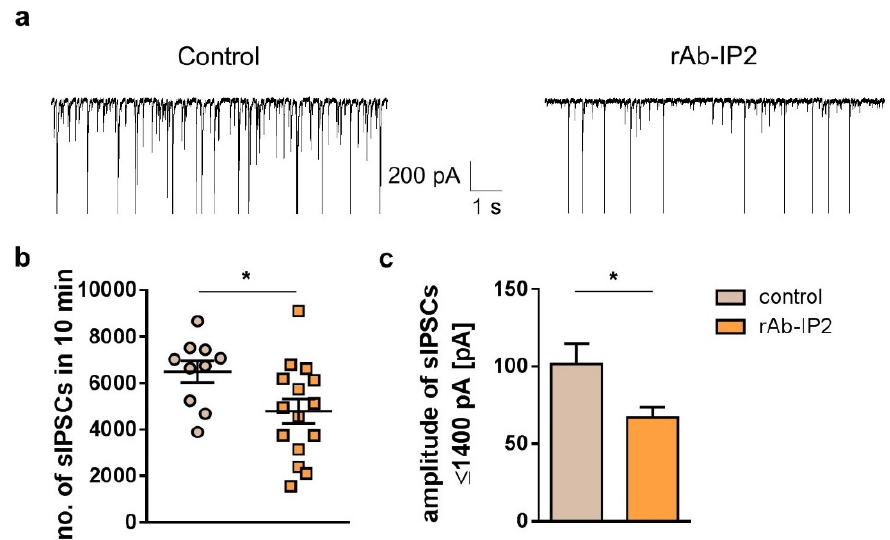
Figure 2. Incubation with the recombinant GABA A receptor autoantibody rAb-IP2 led to both de- creased number and amplitude of spontaneous inhibitory postsynaptic currents (sIPSCs) in pyramidal CA3 neurons. ( a ) Exemplary traces show GABA-mediated synaptic currents in rAb-IP2-incubated pyramidal neurons and controls. For illustration purposes, the amplitude of the high-amplitude currents is cut at 800 pA. ( b ) rAb-IP2-incubated neurons showed a significantly reduced number of sIPSCs in comparison with controls. ( c ) rAb-IP2 led to a significant reduction in the amplitude of sIPSCs when sIPSCs ≤ 1400 pA were analyzed. * p < 0.05, ns: not significant.